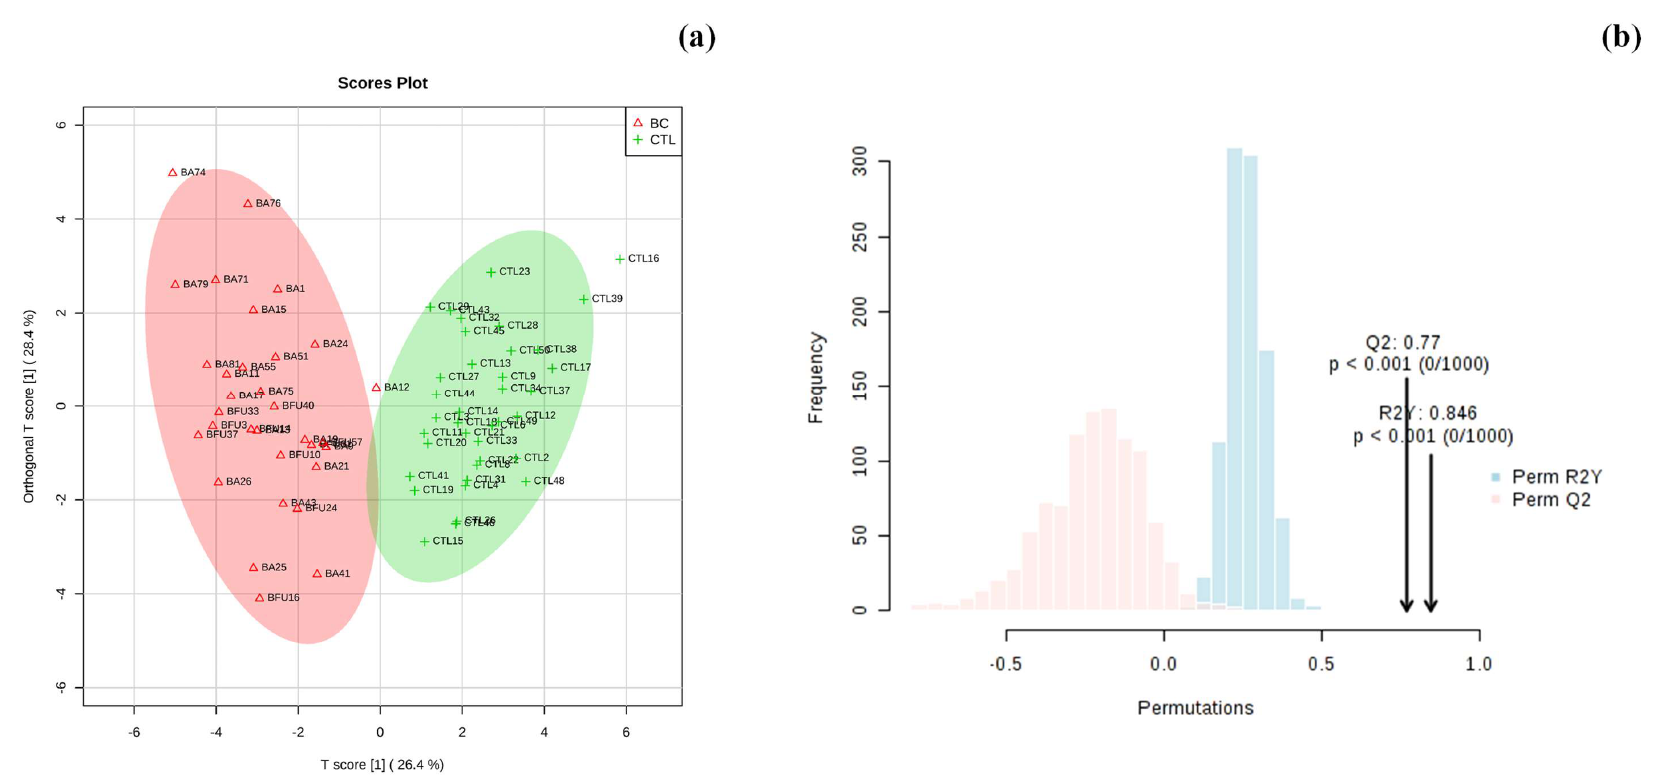
Figure 4. ( a ) Loading score plots of orthogonal projection to latent structure discriminant analysis (OPLS-DA), and ( b ) model validation by the permutation test based on 1000 permutations of metabolites obtained by 1H NMR analysis of urine samples from the two groups under study. The p -value based on permutation was p < 0.001 (0/1000).